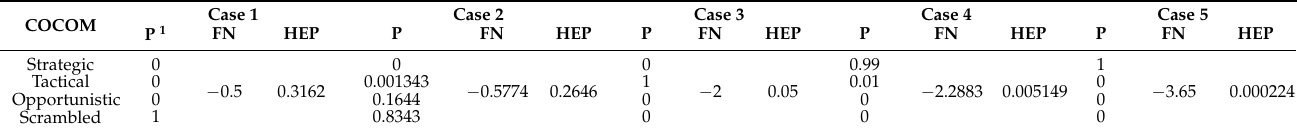
Table 12. The probabilities of the COCOMs and the human error probabilities (HEPs) for five cases.